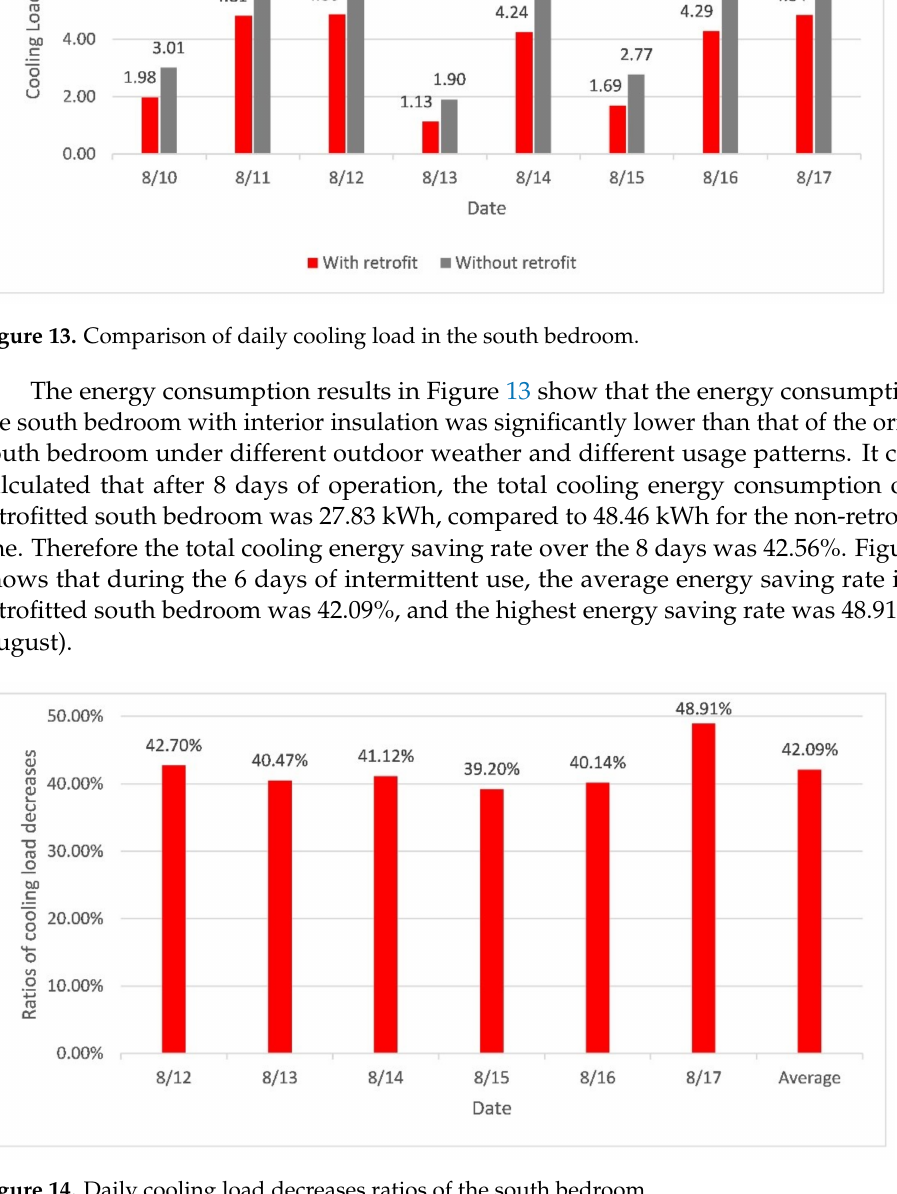
Figure 14. Daily cooling load decreases ratios of the south